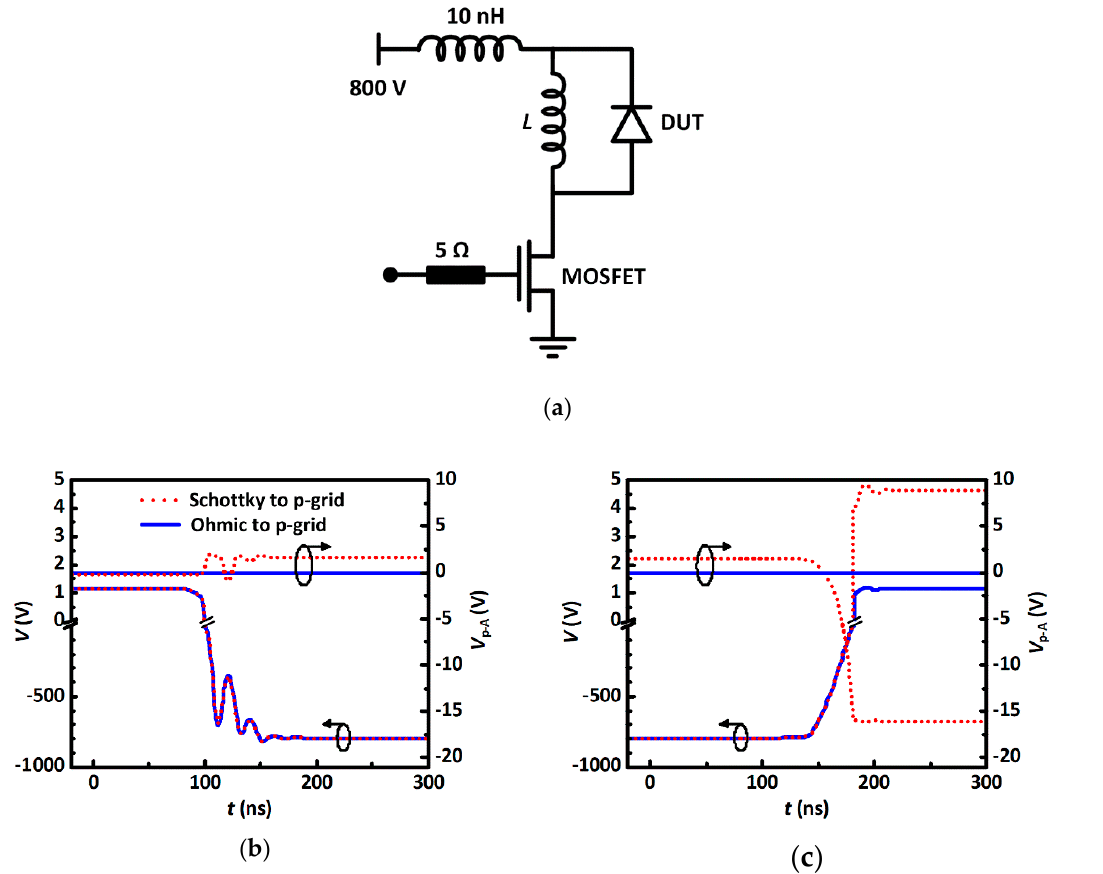
Figure 3. ( a ) The circuit used to test the switching characteristics of the SiC JBS diodes. A SiC MOSFET is used as the switch. The driving signal is switched between − 5 and +15 V to set the MOSFET to o ff - and on-state, respectively. ( b ) The turn-off transient of the SiC JBS diode by switching on the MOSFET (the moment when the driving signal is switched to +15 V is marked as t = 0 ns). ( c ) The turn-on transient of the SiC JBS diode by switching off the MOSFET (the moment when the driving signal is switched to − 5 V is marked as t = 0 ns.